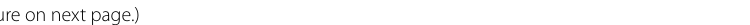
(See figure on next page.) Fig. 2 TOP2A knockdown inhibits proliferation, causes cell cycle arrest, and induces apoptosis in trophoblasts. A TOP2A expression was analysed after specific sh-RNA transfection. B mRNA levels of TOP2A were detected in JEG-3 cells after the indicated treatment. C The effect of TOP2A knockdown on the protein levels of cleaved-caspase3 and caspase3 were analysed using western blot analysis. D q-PCR was used to analyse the mRNA levels of Ki67 , Caspase7 , Bax, and Bim after TOP2A knockdown. E The effects of TOP2A on cell proliferation was assessed using EdU assay. F TUNEL assay was used to assess the effect of TOP2A knockdown on apoptosis. G Apoptosis was assessed via flow cytometry analysis. H Changes in cell cycle in treated JEG-3 cells. Each in vitro experiment was repeated three times, and data are presented as the mean *** P < 0.001, **** P < 0.0001. ns no statistical difference. Scale bar: 100